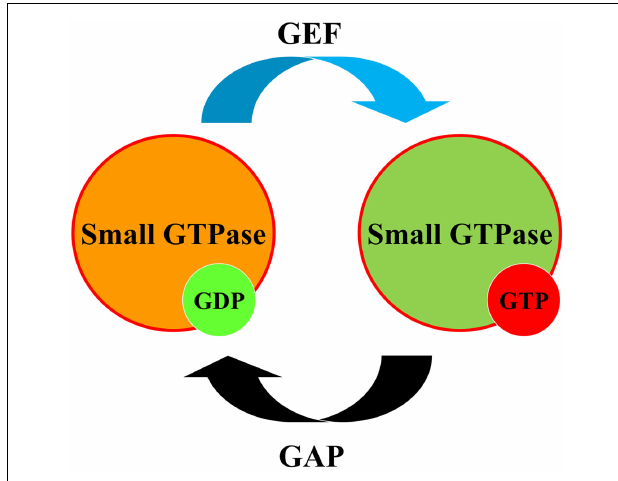
FIGURE 1 | Regulation of small GTPases. Small GTPases (small G proteins) act as molecular switches to regulate downstream effectors which can exist either in GDP or GTP-bound state. To perform their regulatory function, small GTPases cycle between GDP-bound inactive states and GTP-bound active states. Guanine Nucleotide Exchange Factor (GEF) converts small GTPase to GTP-bound form. GTPase-activating protein (GAP) promotes GTPase activity of small G proteins facilitating its return to GDP-bound form.